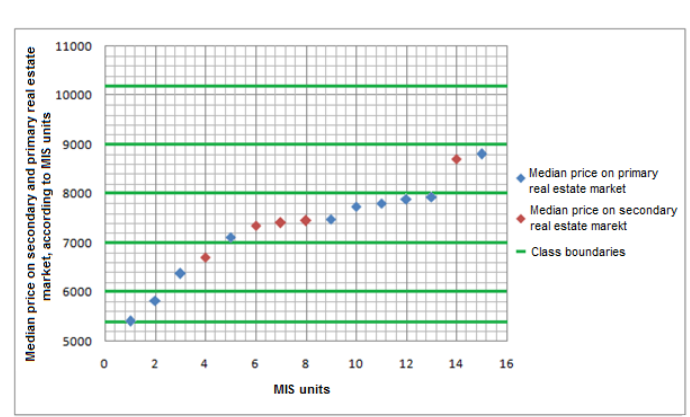
Fig. 2. Median transaction prices of residential premises in złotys per square metre on the primary and secondary markets, according to MIS units (source: own elaboration)